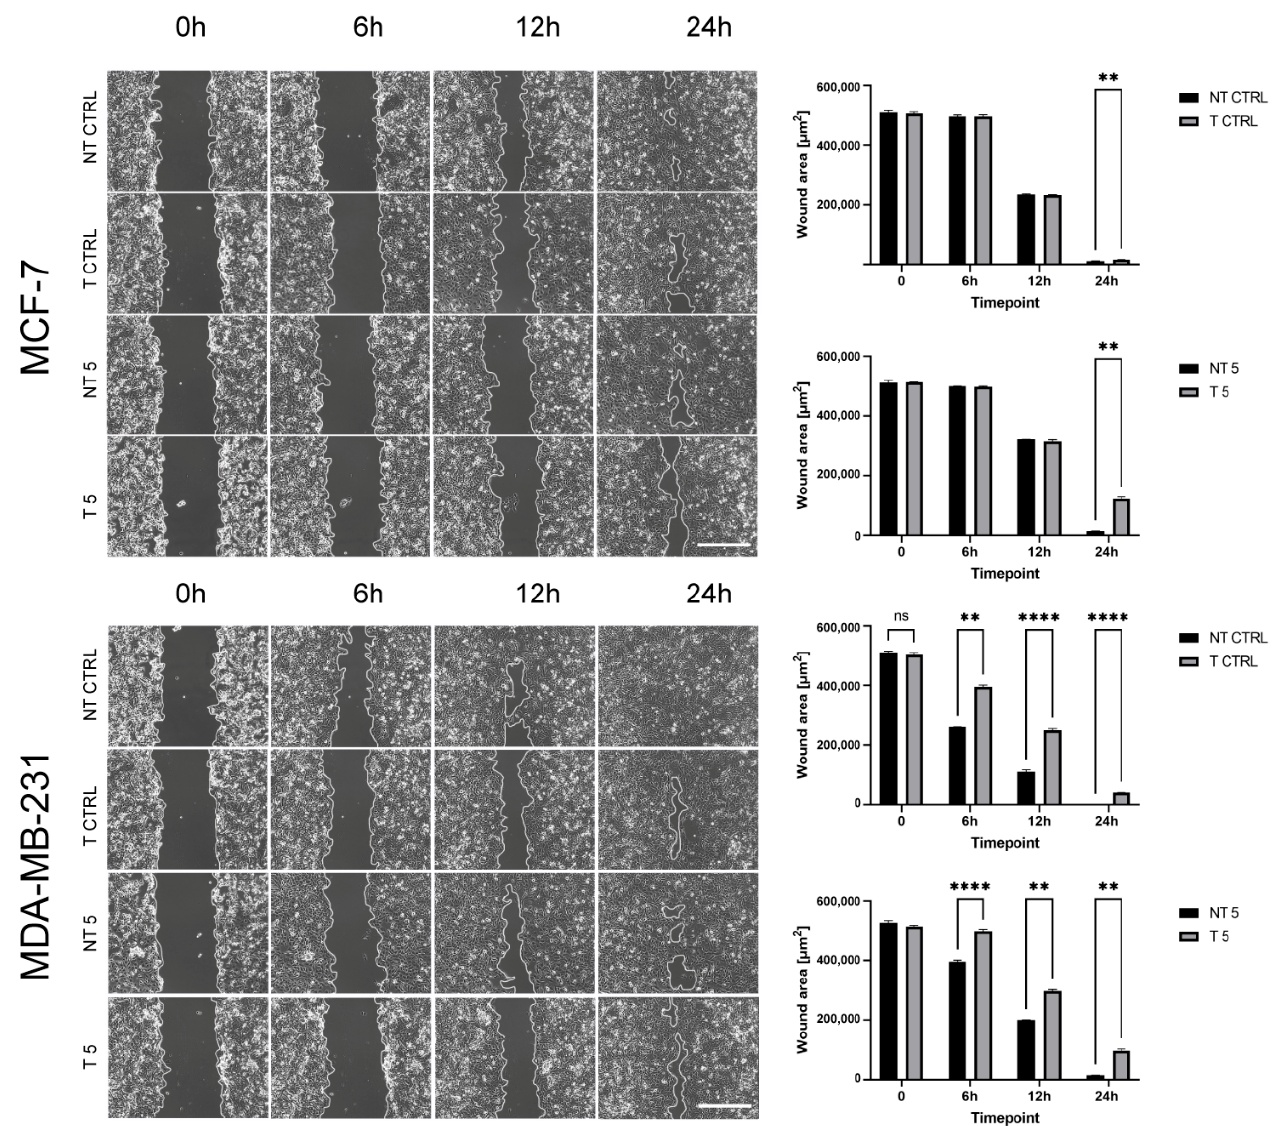
Figure 5. The effect of MMP-9 downregulation on metastasis potential of breast cancer cell lines—Wound healing assay. NT—non-transfected cells, T—cells transfected with MMP-9 siRNA, NT5 and T5 non-transfected and transfected cells treated with 5 mM cyclophosphamide for 24 h. Representative image of Wound healing assay (Bar = 50 µ m) and wound area in timepoints. Statistically significant differences were marked with ‘**’ p ≤ 0.01, and ‘****’ p ≤ 0.0001 (Kruskal-Wallis test).